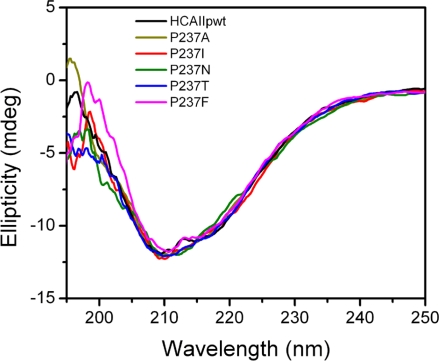
Far-UV CD spectra of HCAIIpwt and the mutants.